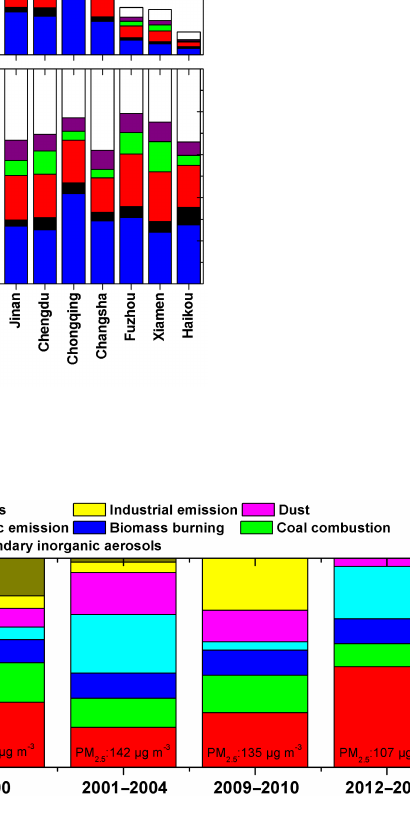
Figure 9. Interannual variations in PM 2 . 5 and the dominant six sources in